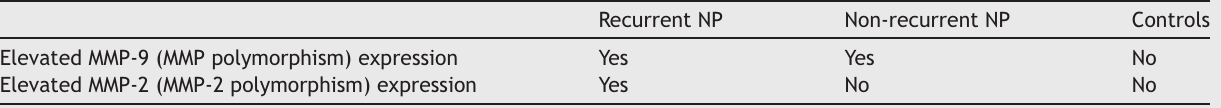
Table 4 Expression of MMP-9 and MMP-2 polymorphisms by immunohistochemistry in chronic rhinosinusitis with nasal polyps (CRSwNP) patients with recurrent and non-recurrent NP.